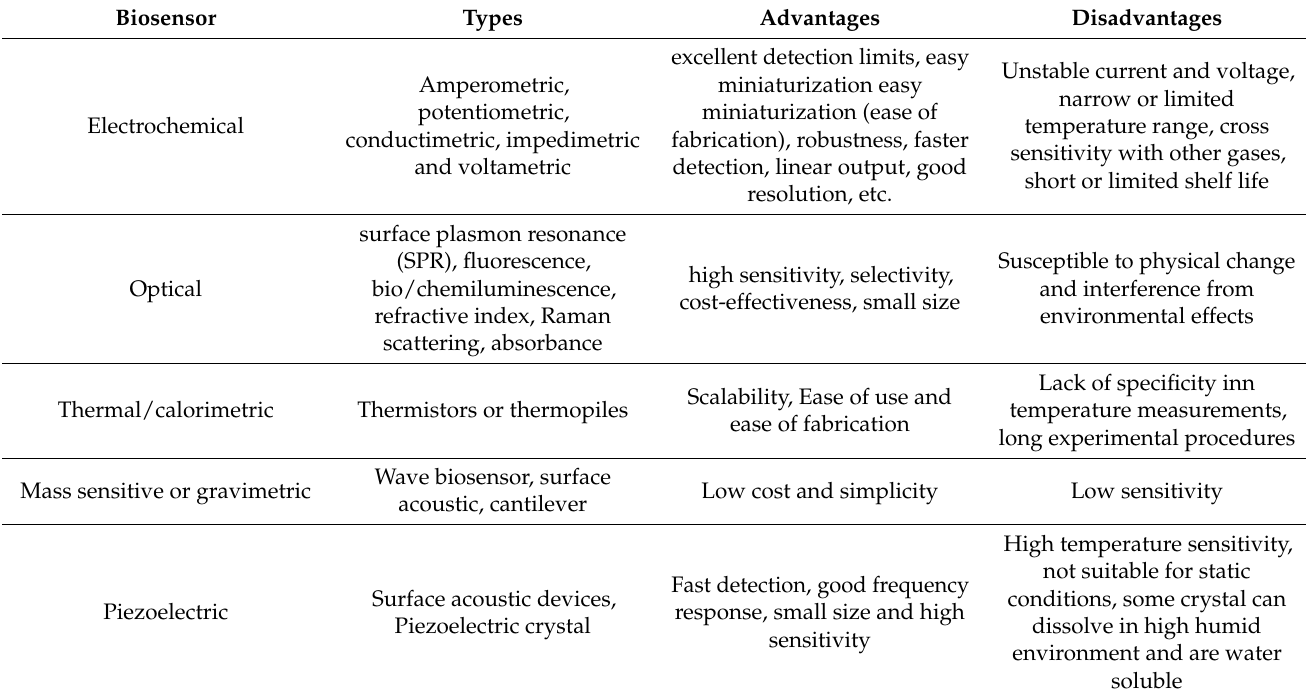
Figure 1. Components of a Biosensor. ( A ) Sample, ( B ) Biorecognition elements, ( C ) Transducer, ( D ) Display. Table 2. Advantage and Disadvantage of Different Types of Biosensors .